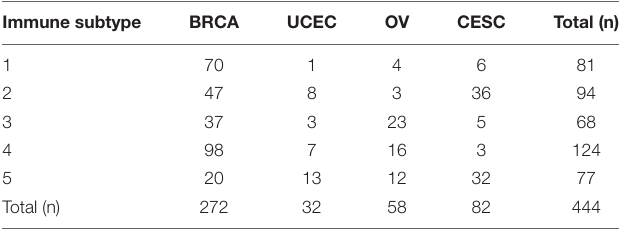
TABLE 3 | Relationship between cancer types and immune